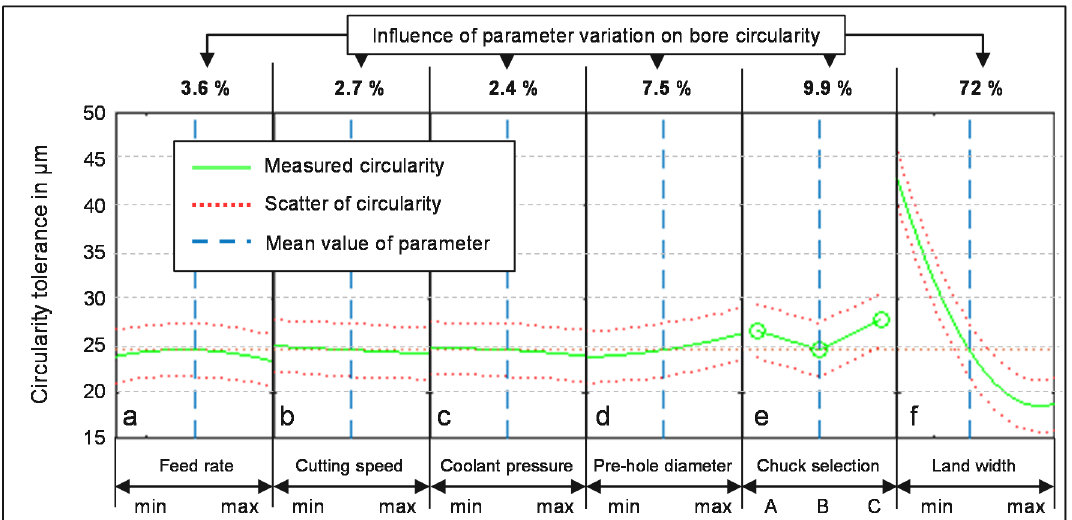
Figure 6. Representation of the influences of the parameters on circularity in an effect diagram .